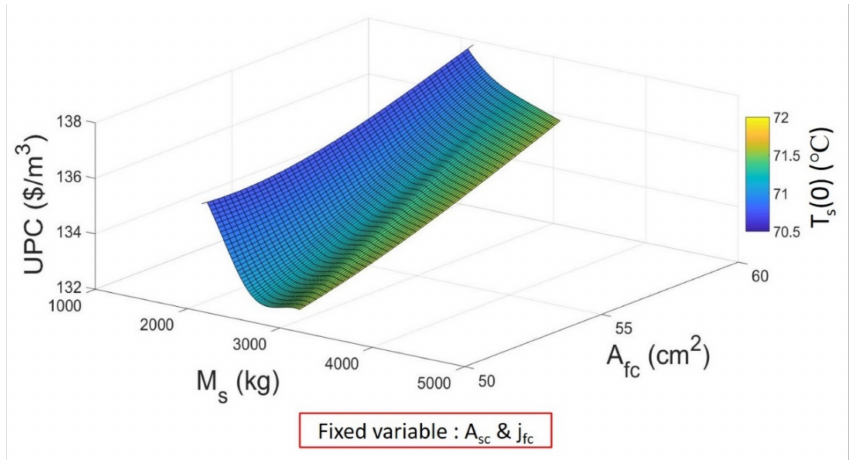
Figure 10. The UPC for the optimization variables of the PEMFC coupled solar-heated membrane distillation system with fmincon (A sc and j fc are fixed).